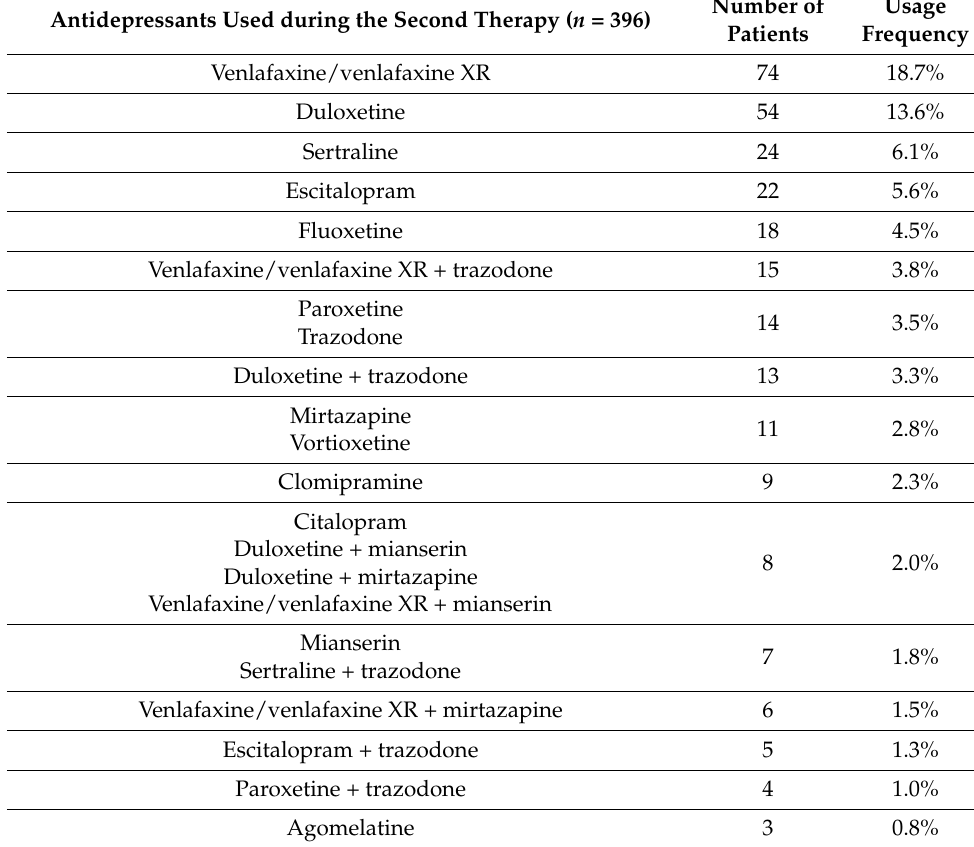
Table 6. Administered second-line antidepressant treatment during the current MDE (therapies with the same frequency of application are grouped